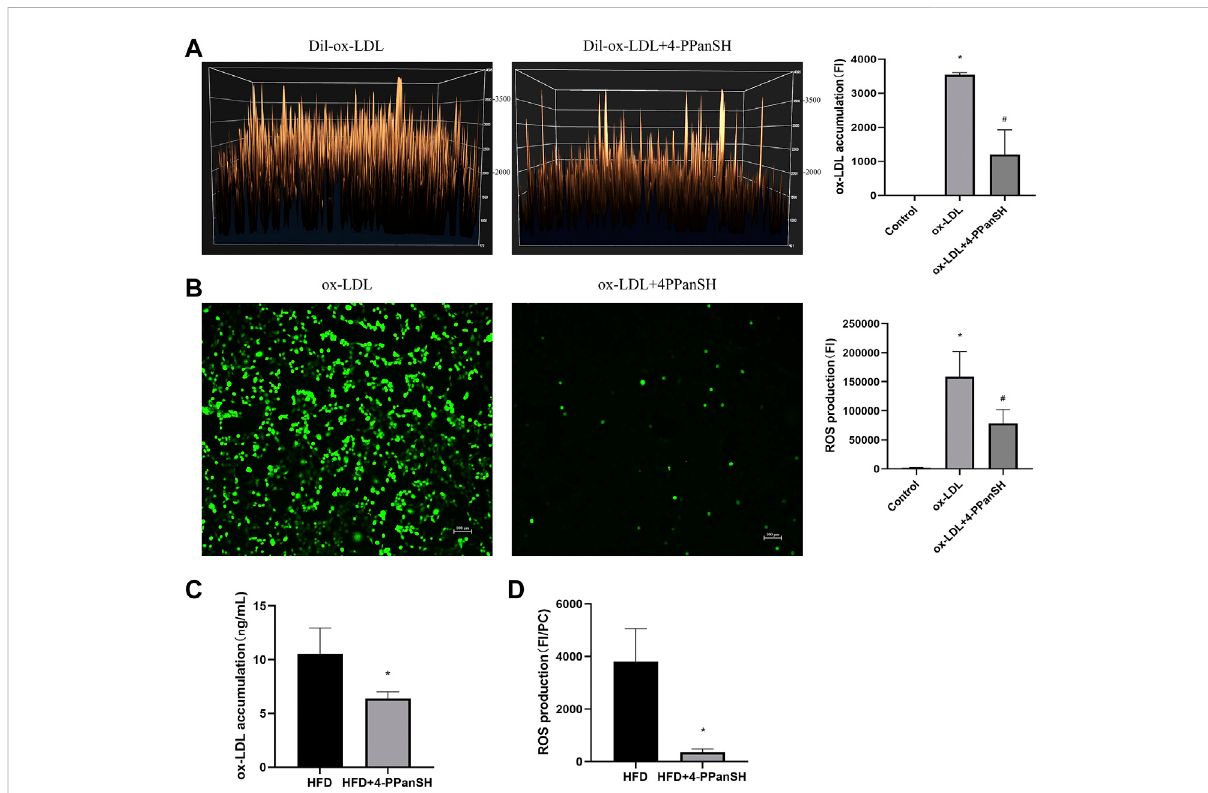
FIGURE 6 4-PPanSH could inhibit ROS generation. (A) Surface fl uorescence intensity of endothelial cells after 24 h of treatment with the addition of Dil- labeled ox-LDL. The accumulation of ox-LDL in HUVECs was detected using a fl uorescence microplate reader ( n = 3). (B) ROS production detected using a fl uorescence microplate reader and fl uorescence microscope in HUVECs ( n = 3). (C) The ox-LDL accumulation of vascular tissues in mice was detected by Elisa. 4-PPanSH inhibited the accumulation of ox-LDL in vascular tissues ( n = 3). (D) ROS production of vascular tissues detected using a fl uorescence microplate reader in mice. The results were expressed as the ratio of fl uorescence intensity to protein concentration. ROS production was inhibited by 4-PPanSH. *Indicates p < 0.05 compared to the control group. #Indicates p < 0.05 compared to the ox-LDL group. FI means fl uorescence intensity. PC means protein